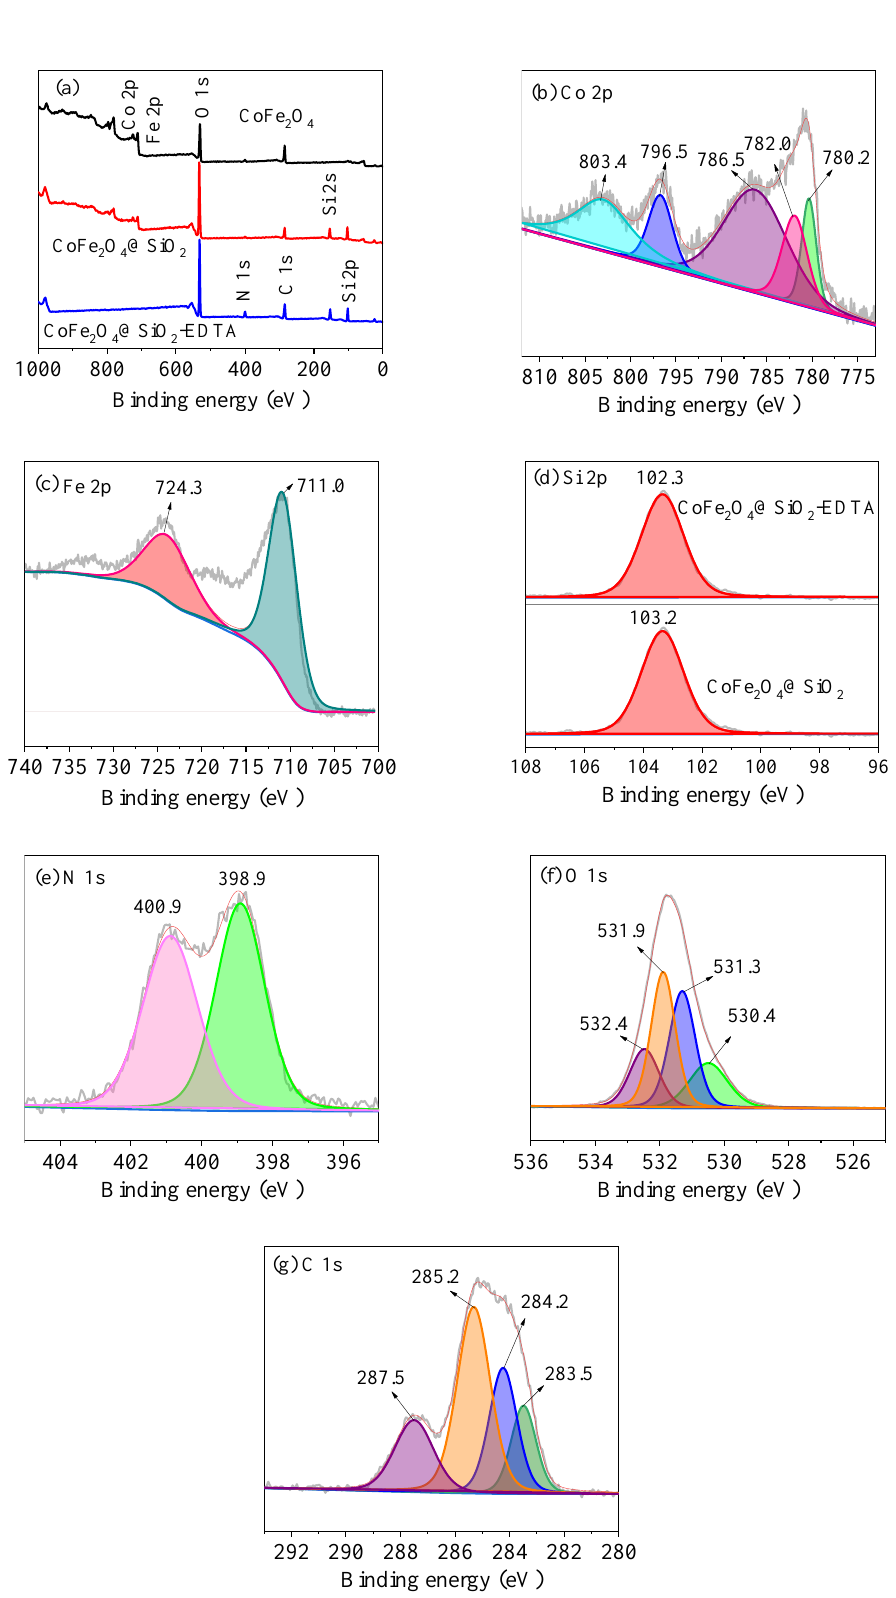
Figure 7. X-ray photoelectron spectroscopy (XPS) survey scan of ( a ) CoFe 2 O 4 , CoFe 2 O 4 @SiO 2 and CoFe 2 O 4 @SiO 2 -EDTA; high-resolution scan of Co 2p ( b ), Fe 2p ( c ), Si 2p ( d ), N 1s ( e ), O 1s ( f ) and C 1s ( g